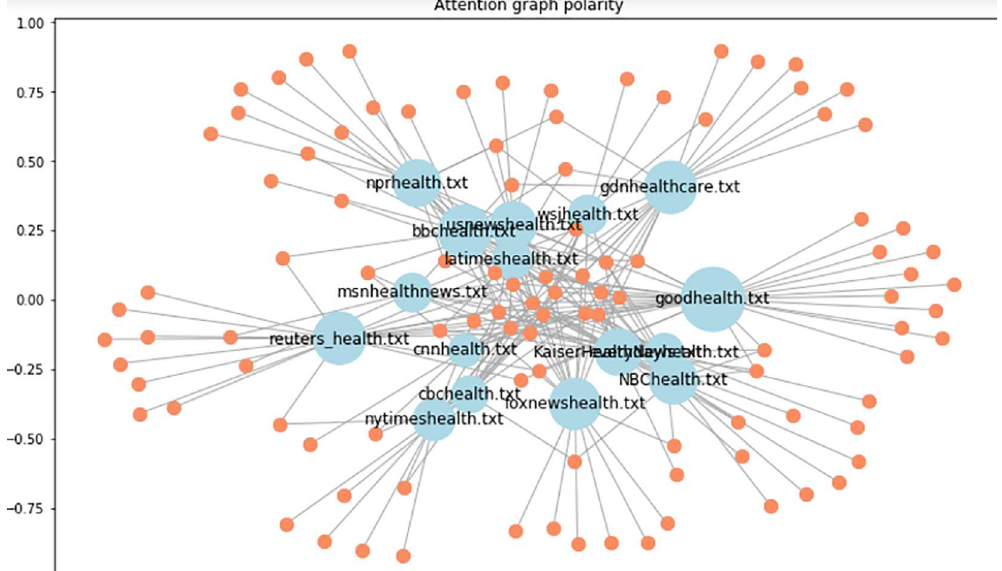
Fig 24. Attention scores for stations’ polarity